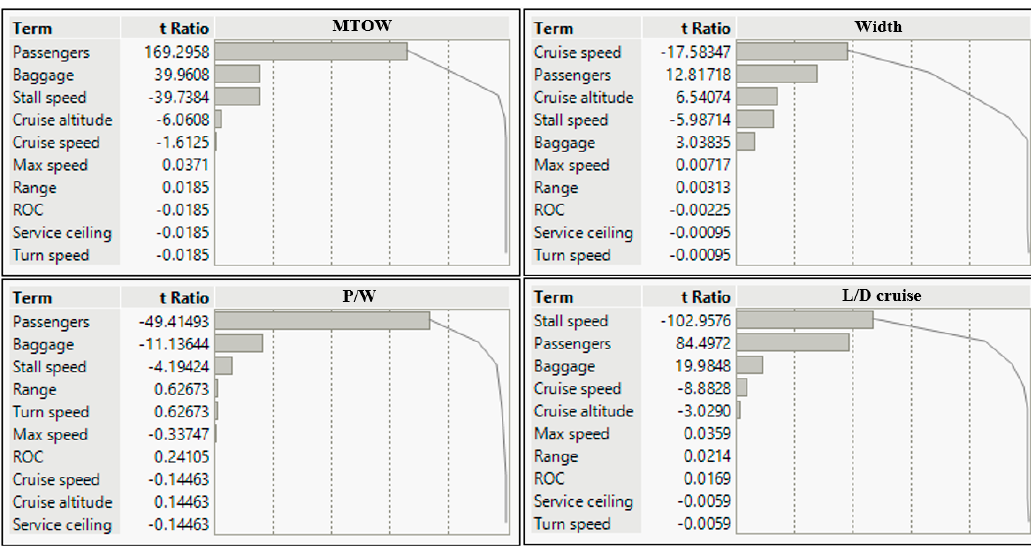
Figure 13. Screening test Pareto plot. Table 15. Independent design parameter p -value.